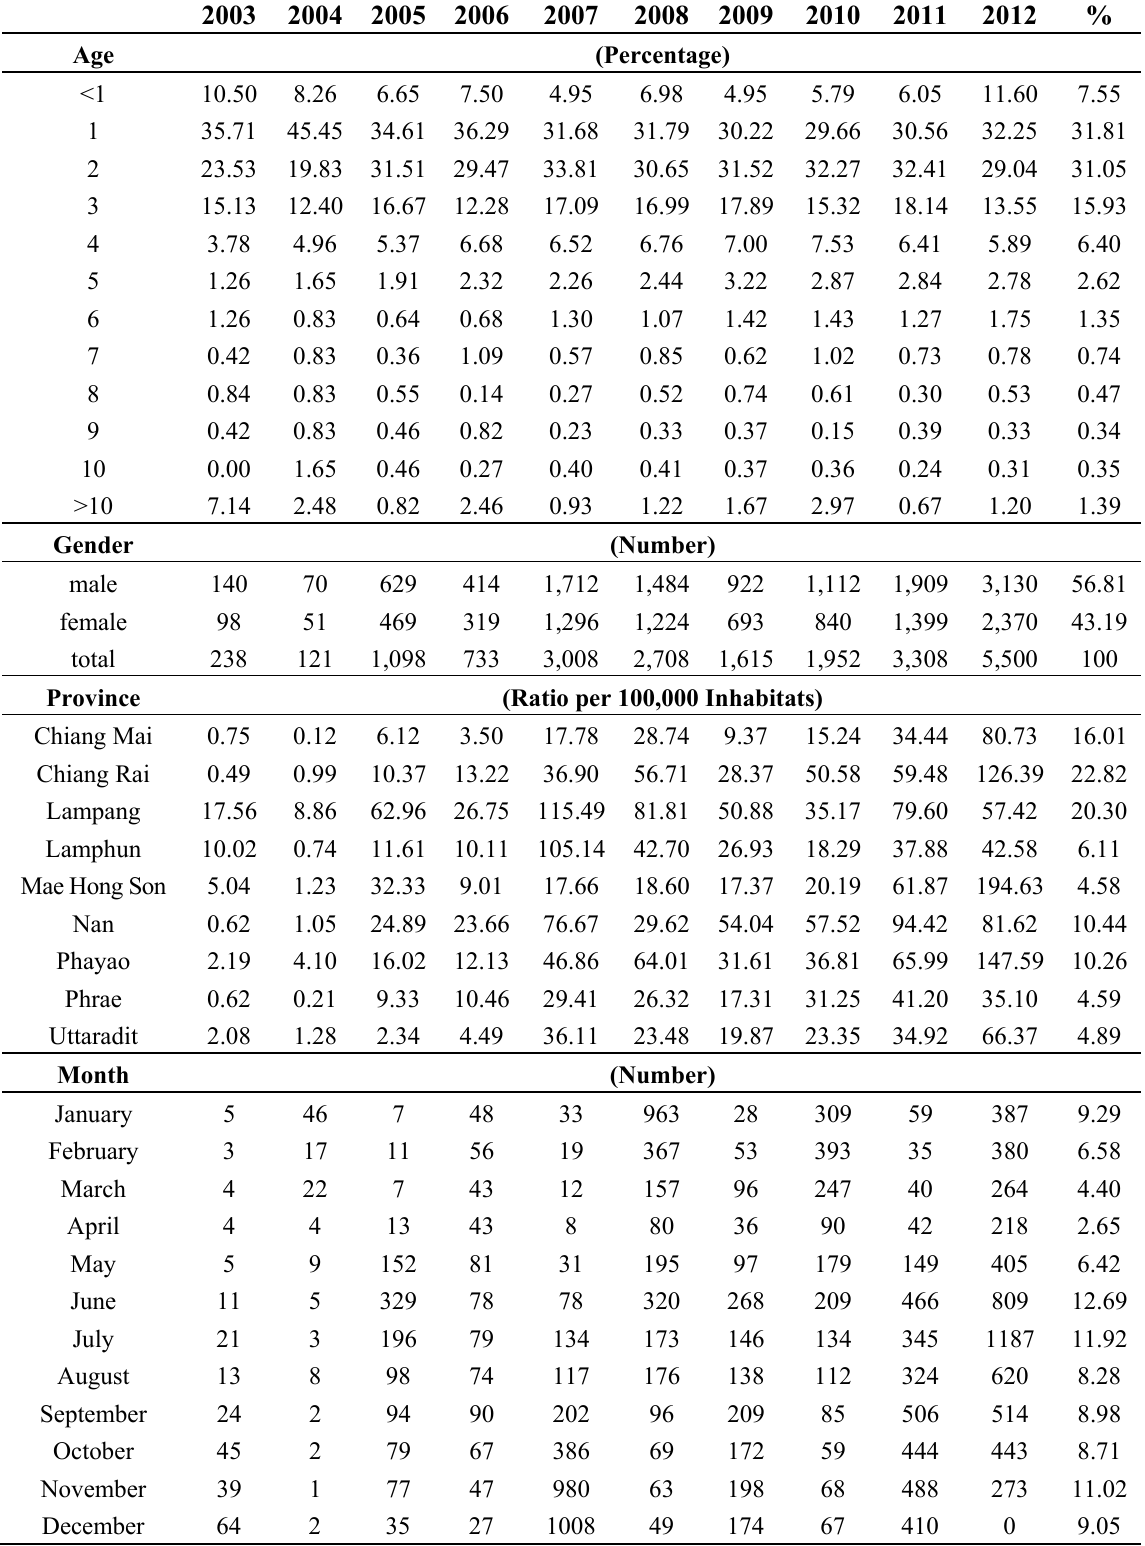
Table 1. Distribution characteristics of HFMD by population, area and time,